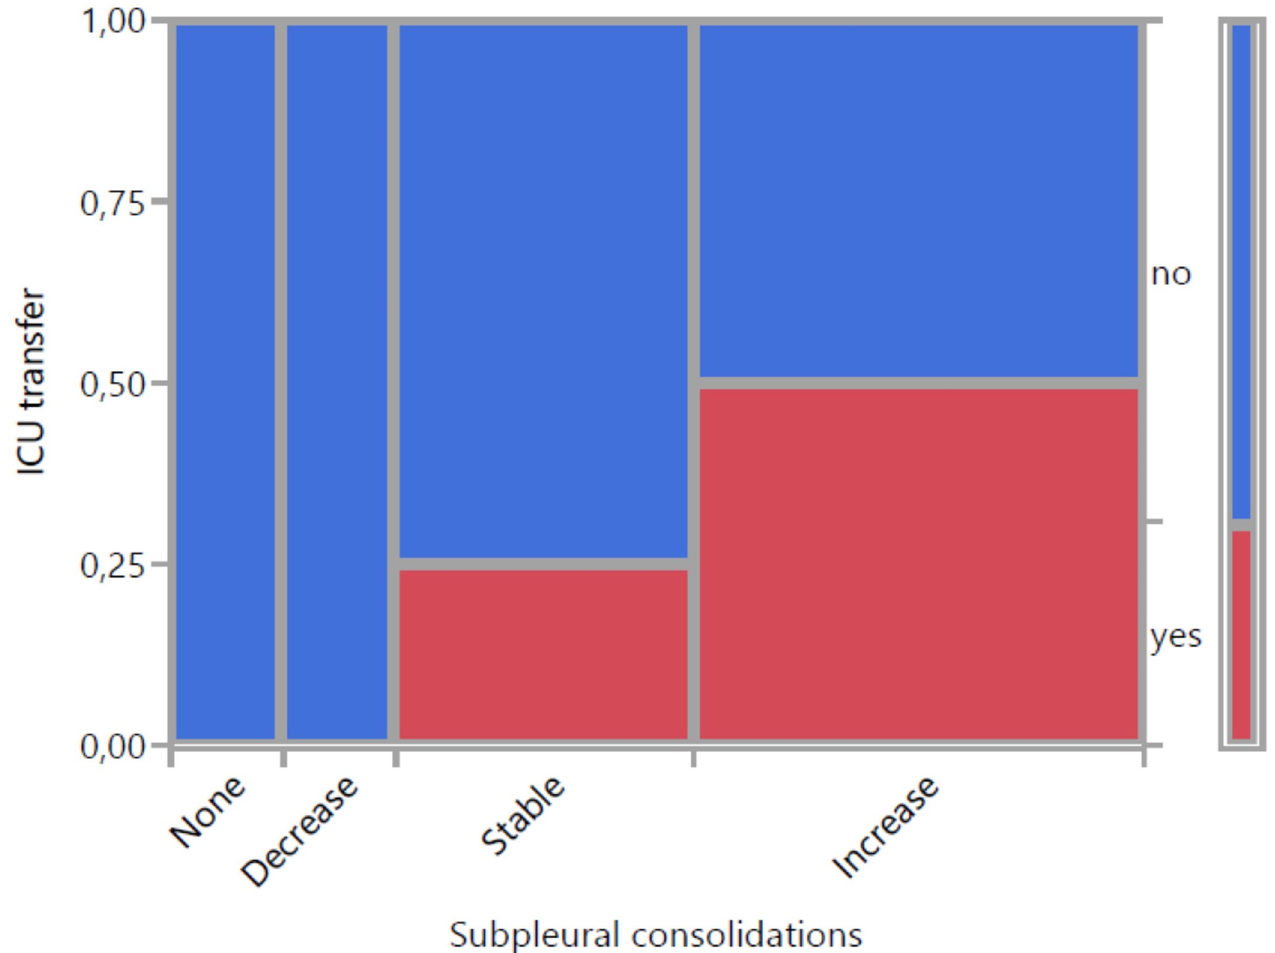
Fig 8. Visualization of change in subpleural consolidations with 4 categories and ICU transfer (mosaic plot).